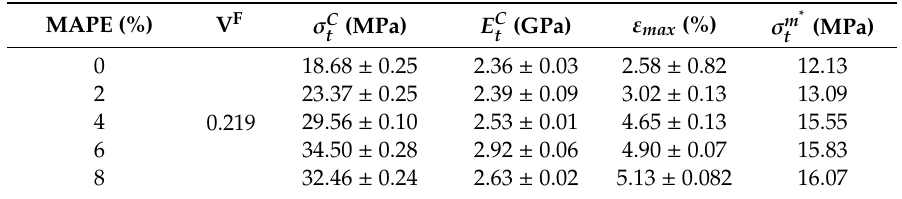
Table 3. Tensile strength, Young’s modulus and strain at break and contribution of the matrix for the 30 wt.% CSF reinforced BioPE